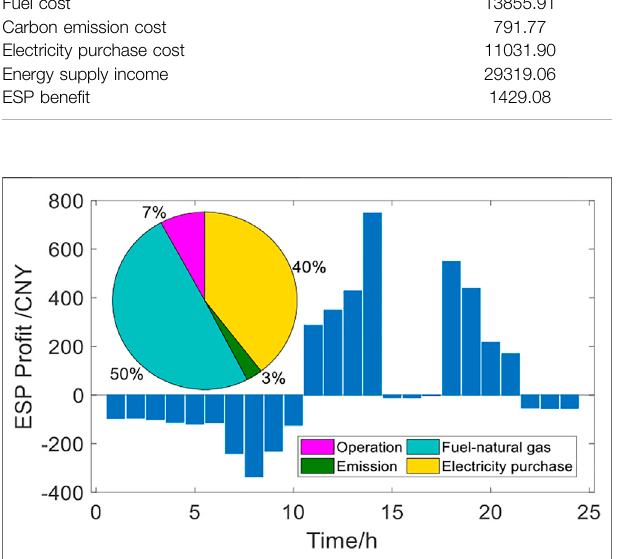
FIGURE 13 | Cost composition and hourly bene fi t of